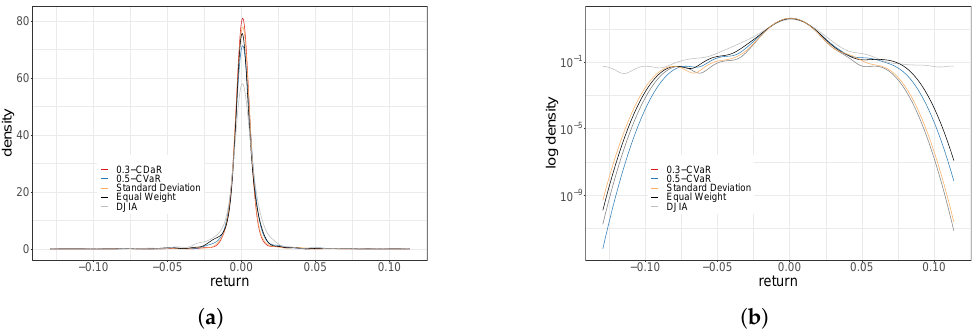
Figure 3. Kernel density estimation and log kernel density estimation. ( a ) Kernel density estimation: this figure plots the kernel density estimation of optimal portfolios with different risk measures, the DJIA index and the equally weighted portfolio. The risk measures include 0-CDaR, 0.5-CVaR and standard deviation. ( b ) Log kernel density estimation: this figure plots the log kernel density estimation of optimal portfolios with different risk measures, the DJIA index and the equally weighted portfolio. The risk measures include 0-CDaR, 0.5-CVaR and standard deviation.